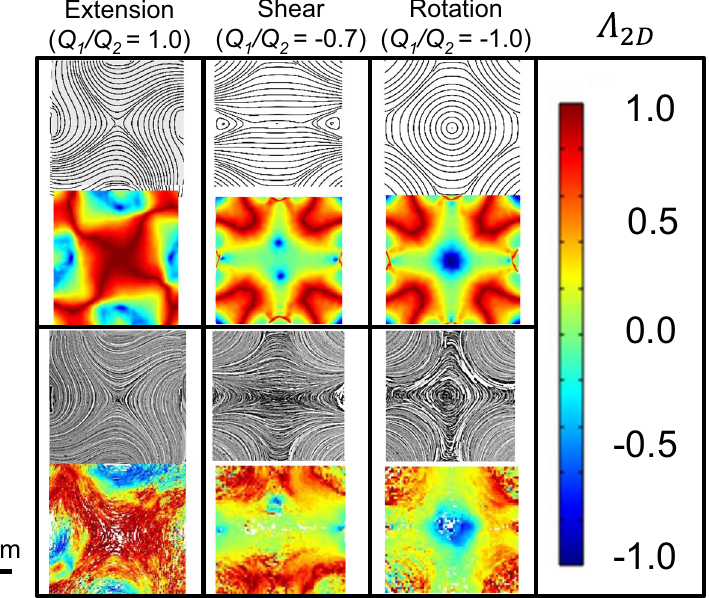
Figure 9. Streamlines (upper) and local flow type parameter ( Λ 2 D , lower) comparisons between simulated (top) and experimentally determined (bottom) flow of a 5 wt% CNC dispersion (shear thinning fluid) at the center plane of the FFoRM geometry. All test conditions correspond to Q 2 = 1.0 mL/min ( Re = 0.005) and the values of Q 1 /Q 2 indicated. Experimental conditions correspond to 〈 Pe r 〉 ~5 for extension, ~3 for shear, and ~1 for rotation in the center plane of the device.